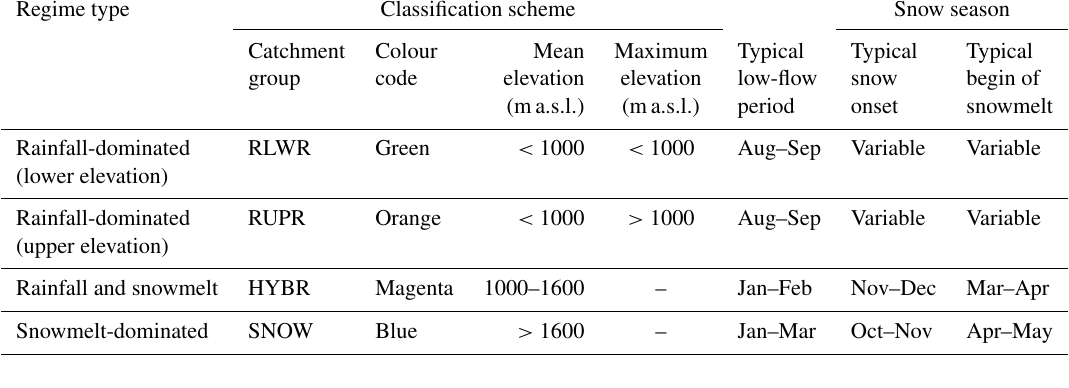
Table 1. Classification scheme separating the catchments into four different groups (abbreviations and colour coded) according to elevation and hydrological regime types. Typical low-flow periods are derived from streamflow data. Information on snow onset and snowmelt periods are derived from the literature (Klein et al., 2016) and generalized for the groups HYBR and SNOW.